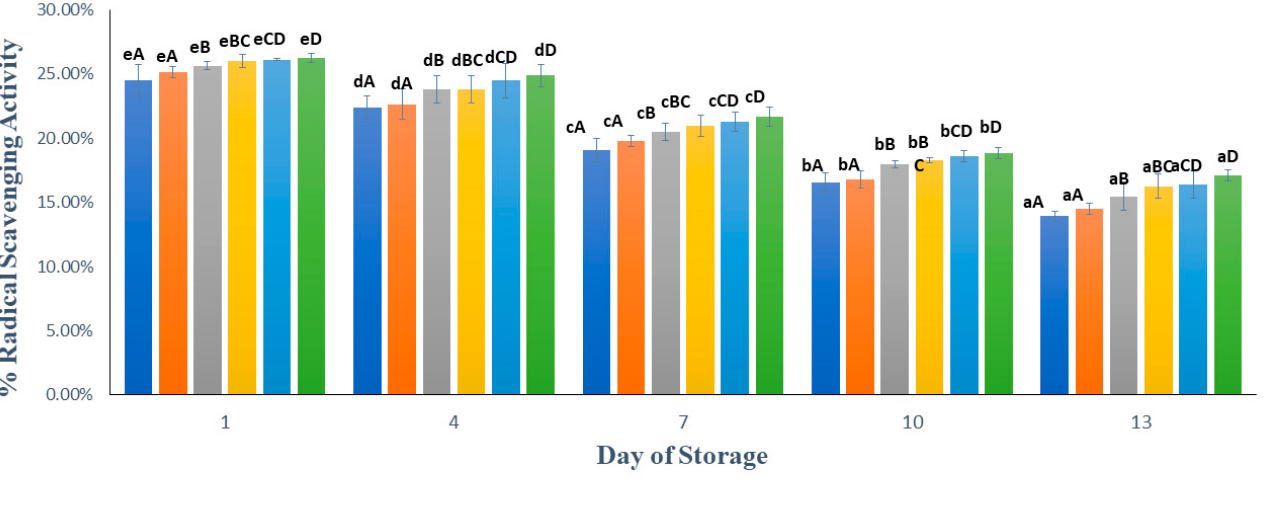
Figure 9. Effect of edible coating of gelatin composite enriched with black tea extract on antioxidant activity (%) of sliced watermelon during storage. The value shown is the average of the three experimental replications. A–D Values followed by the same capital letters showed no significant difference ( p > 0.05) between treatments on the same day. a–e Values followed by the same non-capital letters showed no significant difference ( p > 0.05) between storage times in the same treatment.